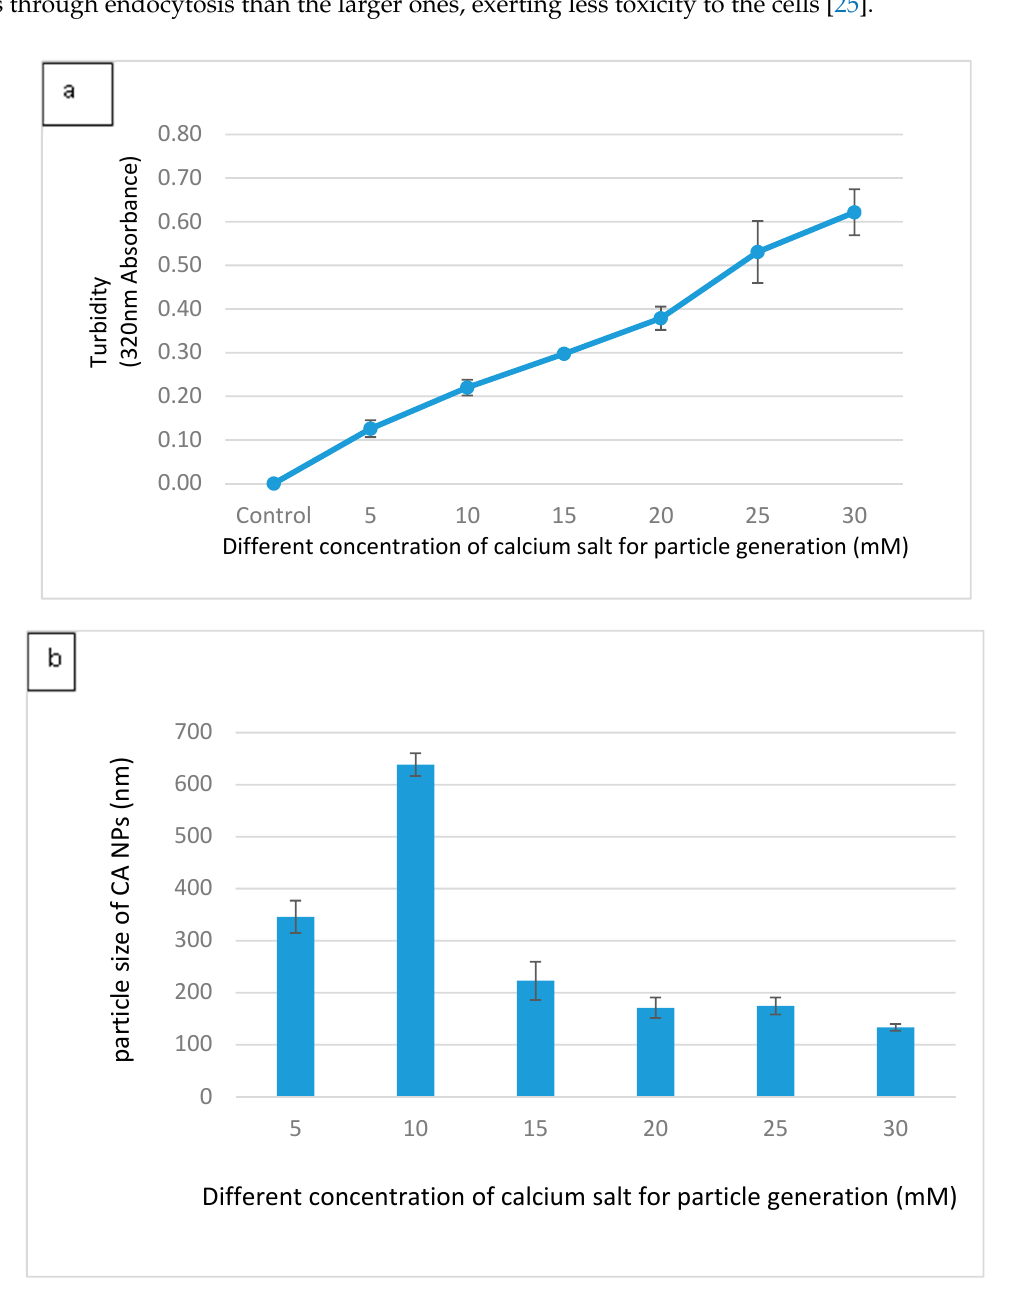
Figure 1. ( a ) Measurement of turbidity at 320 nM as an indicator of particle growth, which was induced by the addition of different concentrations of Ca 2+ to 200 μ L bicarbonate-buffered solution (pH 7.4), followed by incubation at 37 °C for 30 min. The data are presented as the mean ± SD of triplicates. ( b ) Particle sizes of CA NPs formed in the presence of varying concentrations of Ca ions. Fabricated particles were analyzed using Zetasizer to obtain the average size. The data are presented as the mean ± SD of triplicates.